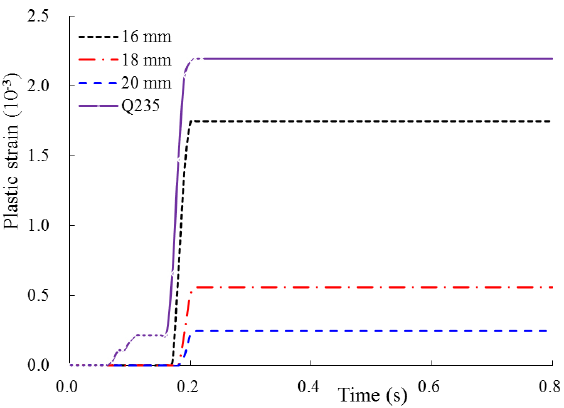
Figure 21. Max plastic strain time-history of steel plates.